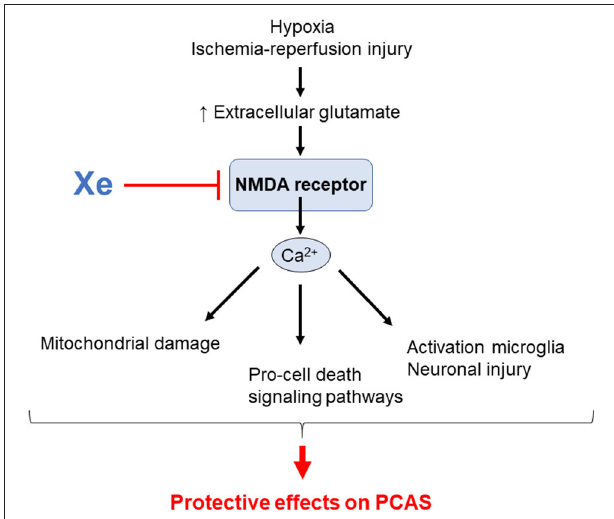
FIGURE 4 | Potential mechanisms by which xenon (Xe) inhalation improves outcomes in post–cardiac arrest syndrome (PCAS). NMDA; N -methyl- D